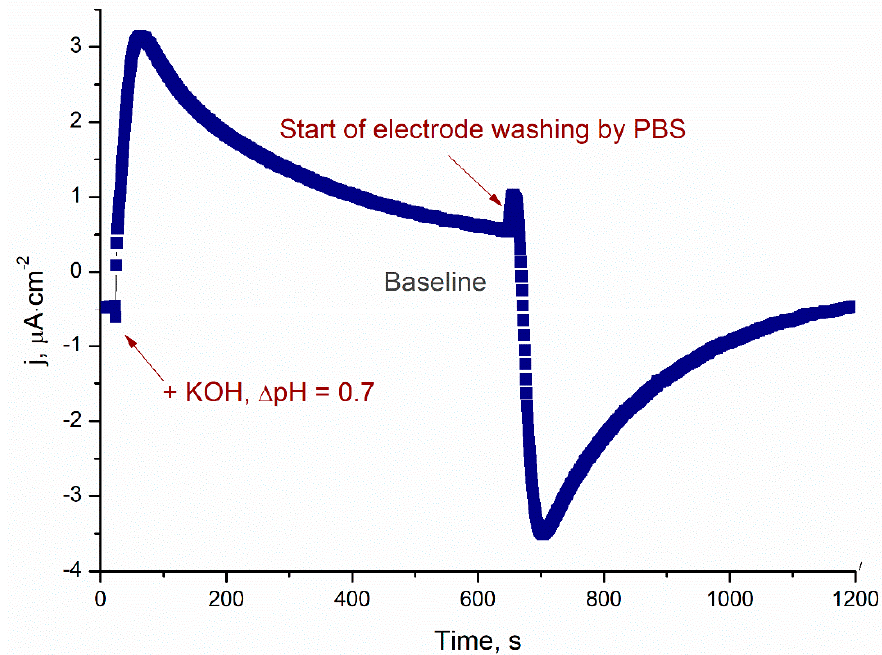
Figure 3. Response of the TRGO ‐ based electrode to an increased pH value of ∆ pH 0.7. Rinsing with default PBS (pH 7.2) starting from 620 s. Applied electrode potential 0.2 V vs. Ag/AgCl.